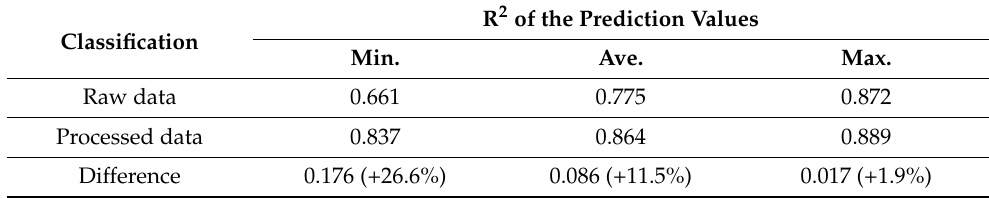
Table 4. AI prediction results for raw and processed